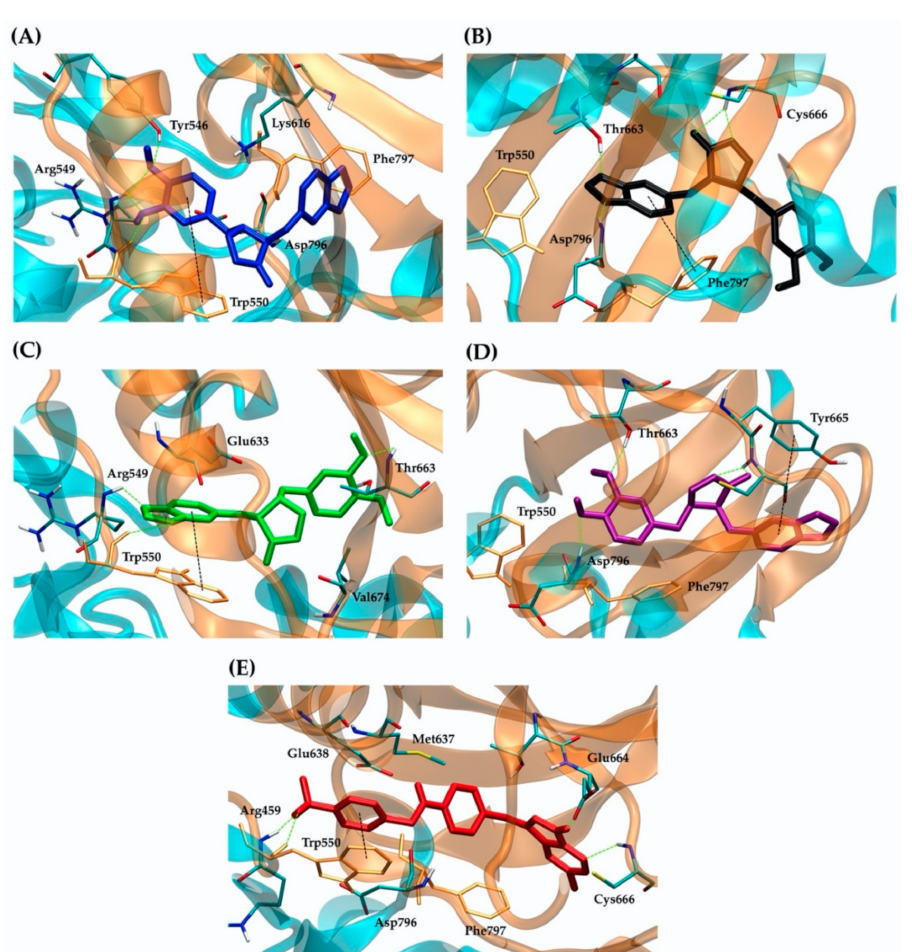
)-kusunokinin Figure 4. Binding interaction of ligands with a CSF1R kinase structure: ( A ) trans -( − (blue); ( B ) trans -(+)-kusunokinin (black); ( C ) cis -( )-isomer (green); ( D ) cis -(+)-isomer (purple); − ( E ) pexidartinib (red). The green dash lines represented hydrogen bonding. Trp550, Tyr665 and Phe797 were responsible for π - π interaction (black dash lines). Docking poses of the ligands and amino acids interacting with the ligands through hydrophobic interaction were shown as sticks. Table 3. Type of interaction between kusunokinin isomers/inhibitor with CSF1R and EGFR. Target and